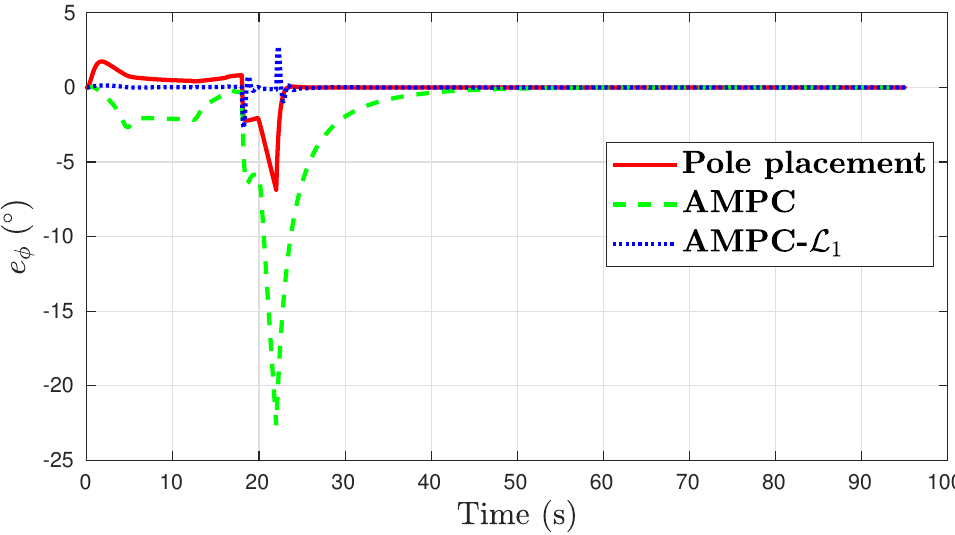
Figure 4. Roll tracking error for the nominal case. The side-slip regulation performance is shown in Figure 5. The stage-separation and reorientation maneuvers produced perturbations in lateral velocity, which translated into disturbances to the side-slip angle. All controllers performed acceptably, keeping the tracking error below 2 ◦